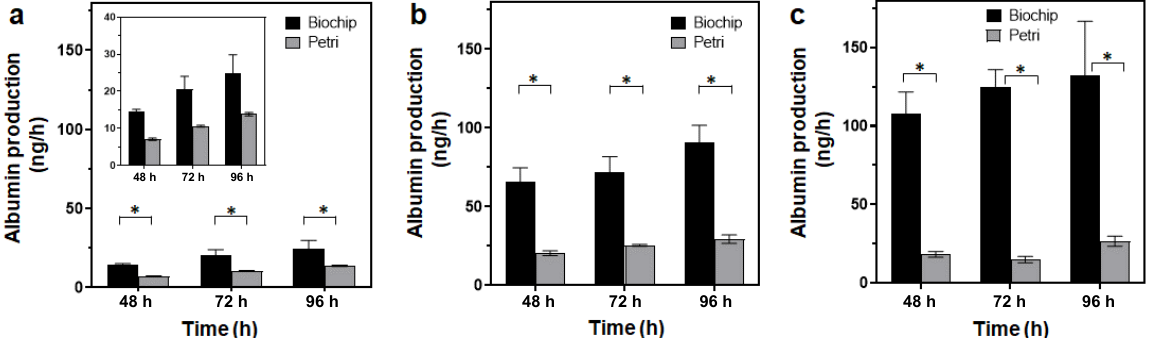
Figure 5. Albumin secretion by HepG2/C3A cultivated in a dynamic biochip and static Petri containing the hydroscaffold. Starting cell density 20,000 ( a ), 125,000 ( b ), and 250,000 cells/cm² ( c ); * p < 0.05 The insert in panel ( a ) is a close-up on the vertical axis. Table 1 summarizes albumin production in the biochip containing a hydroscaffold and